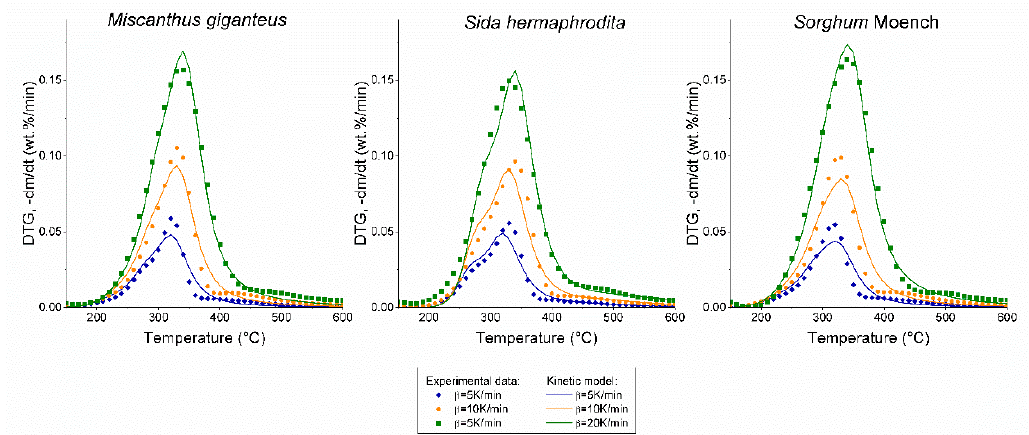
Figure 5. Experiment and generated DTG curves using kinetic model involving three parallel n th-order reactions for Miscanthus giganteus , Sida hermaphrodita , and Sorghum